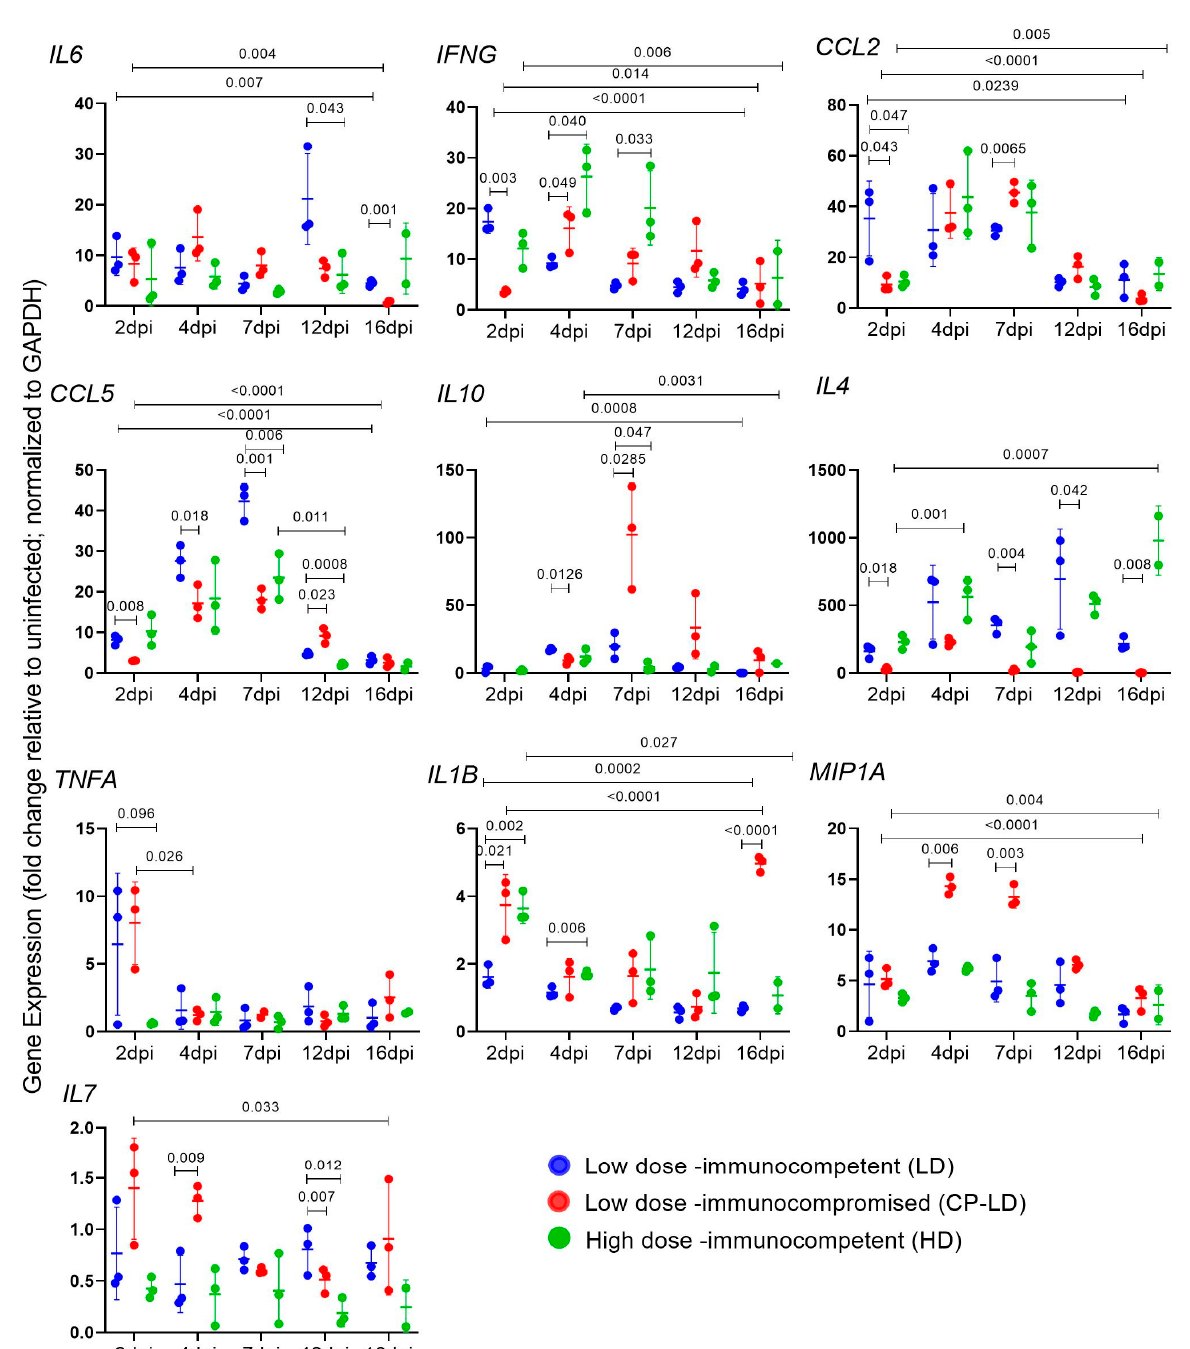
Figure 2. Expression of pro and anti-inflammatory cytokines/chemokines in SARS-CoV-2-infected hamster lungs. Comparative expression levels of IL6, IFN γ , CCL2, CCL5, IL10, IL4, TNF α , IL1 β , MIP1 α , and IL7 gene transcripts in immunocompetent LD (blue) and HD (green), or immunocompromised LD (CP-LD) SARS-CoV-2-infected hamster lungs collected at 2, 4, 7, 12, and 16 dpi. ( n = 3 for each time point and condition repeated 3 times; each dot represents the average of 3 technical replicates). The gene expression levels of target genes were normalized to GAPDH transcript levels and represent the fold change in expression compared to uninfected hamsters. Statistical analysis was performed using an unpaired Student’s t -test with Welch correction. Data represent mean ± SD